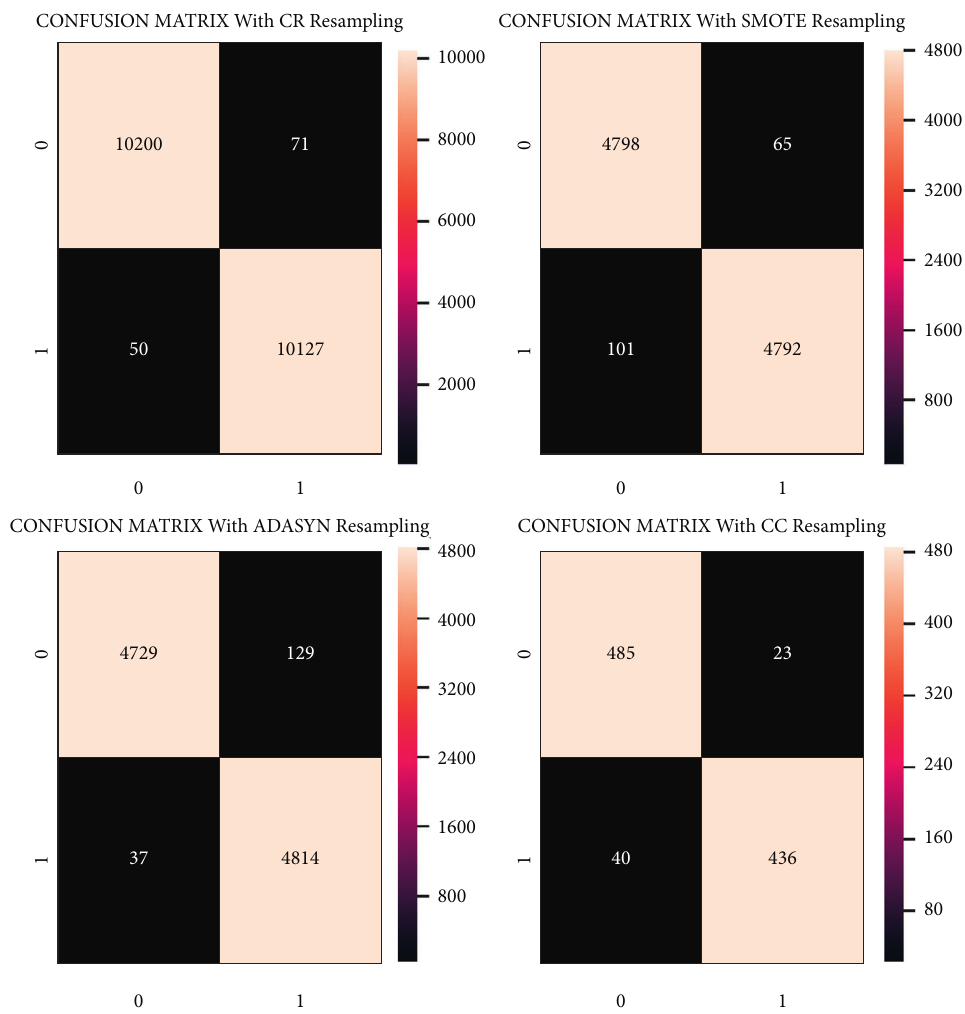
Figure 4: Confusion matrix of best performer ETC using all resampling techniques.